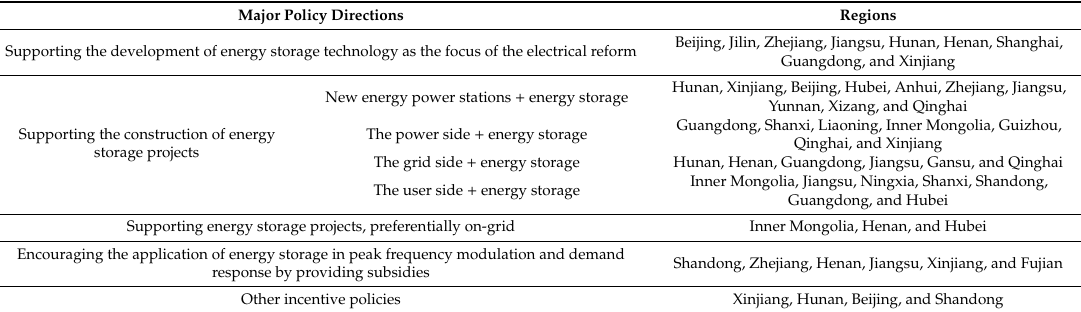
Table 1. Policy documents related to the energy storage of local